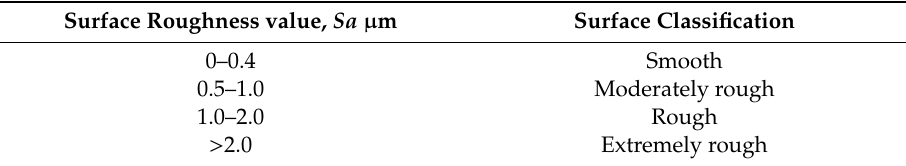
Table 4. Classification of materials surface roughness [38].